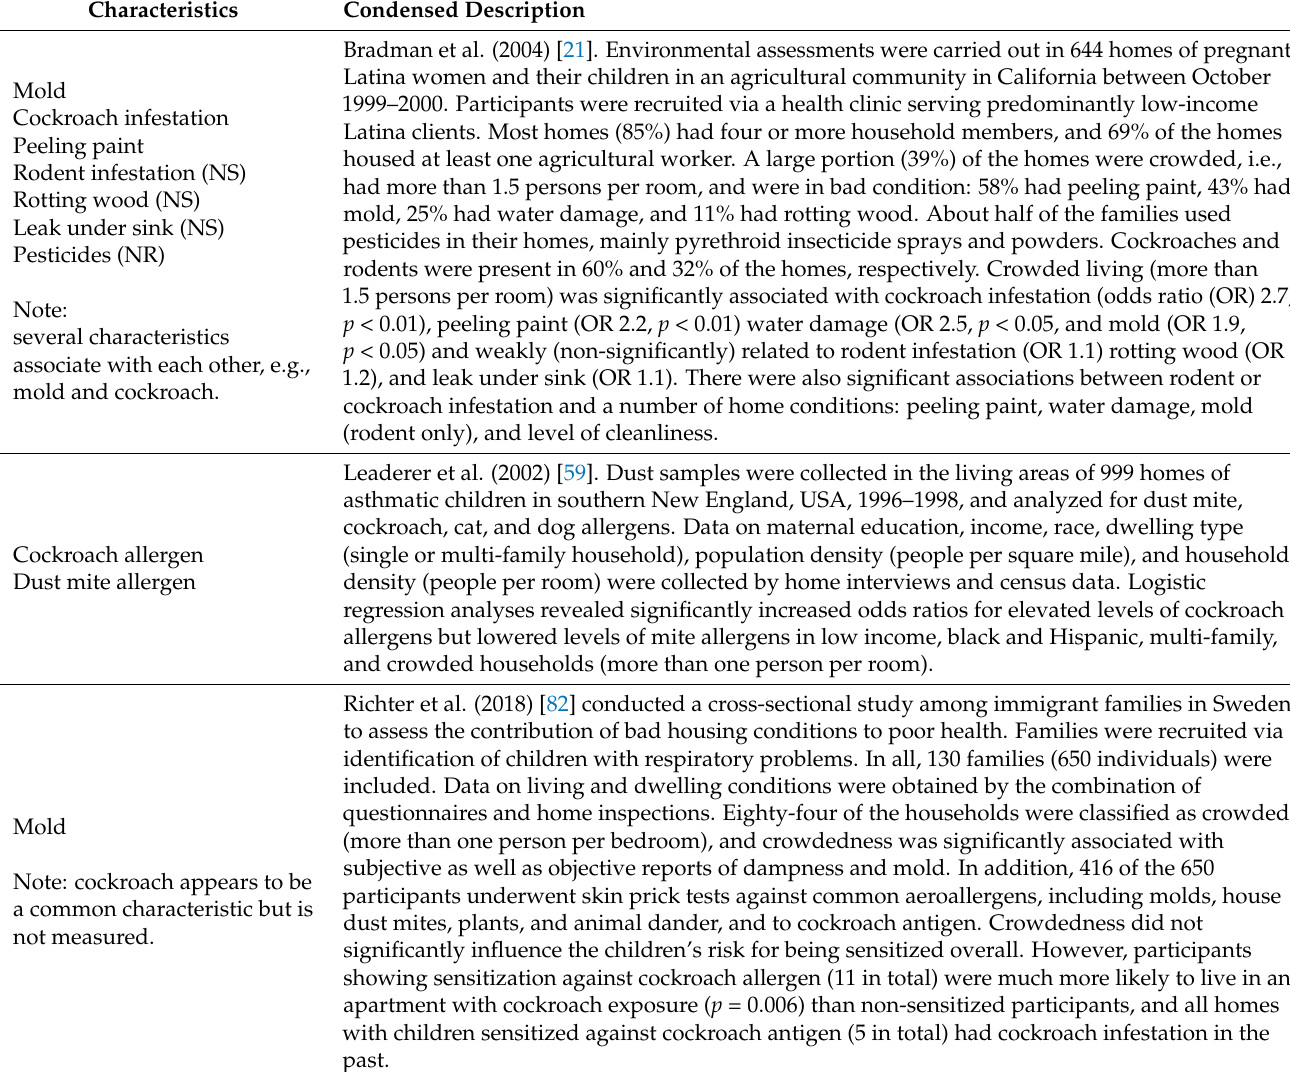
Table 1. Condensed description of the six studies in category A and extracted specific hazardous dwelling condition characteristics from each